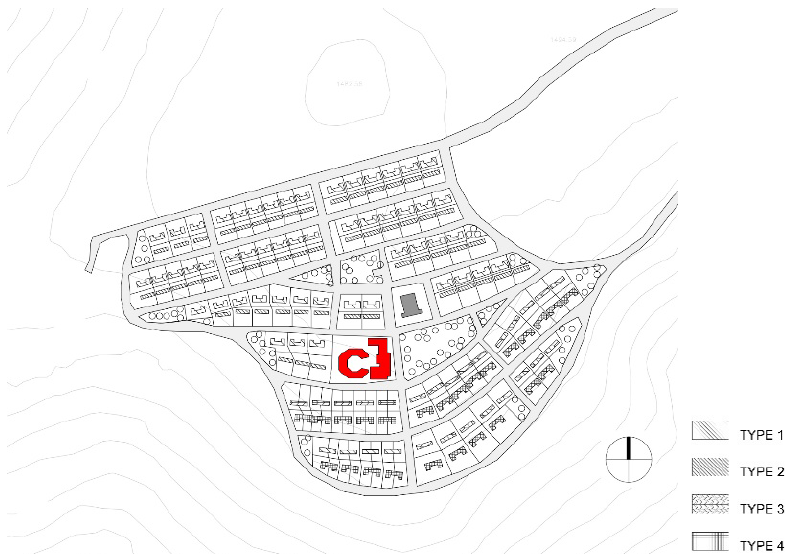
Figure 31. The Umudugudu Kigali 2020: 4 different twin house types. Drawing by Manlio Michieletto. Valley. At the top of the settlements, the smallest and